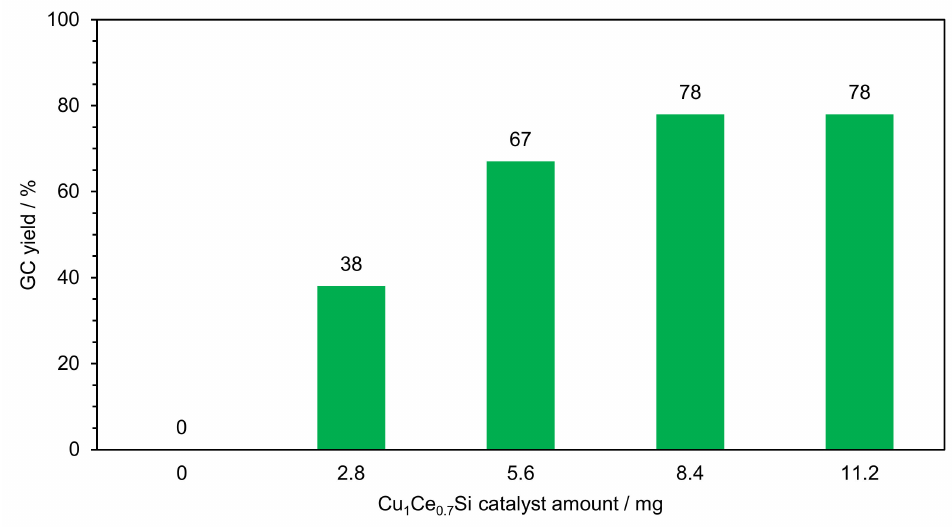
Figure 10. Effect of the amount of the Cu 1 Ce 0.7 Si catalyst on the product yield. Reaction conditions: 1,1-diphenylethylene (0.3 mmol); THF (1 mL); DTBP (4 equiv.); KI (20 mol%); 120 ◦ C; under air for 20 h.